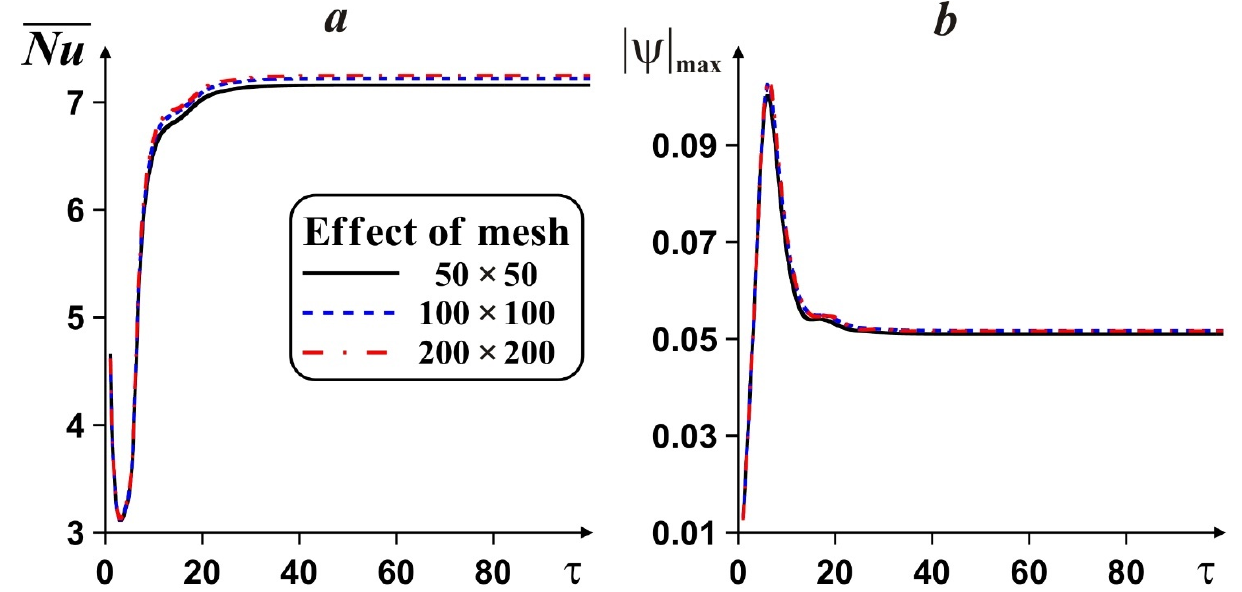
Figure 2. Evolution in time of mean Nusselt number ( a ) and fluid flow rate ( b ) with mesh parameters for Ra = 10 5 , Pr = 0.71, Da = 10 − 2 and ε = 0.9.